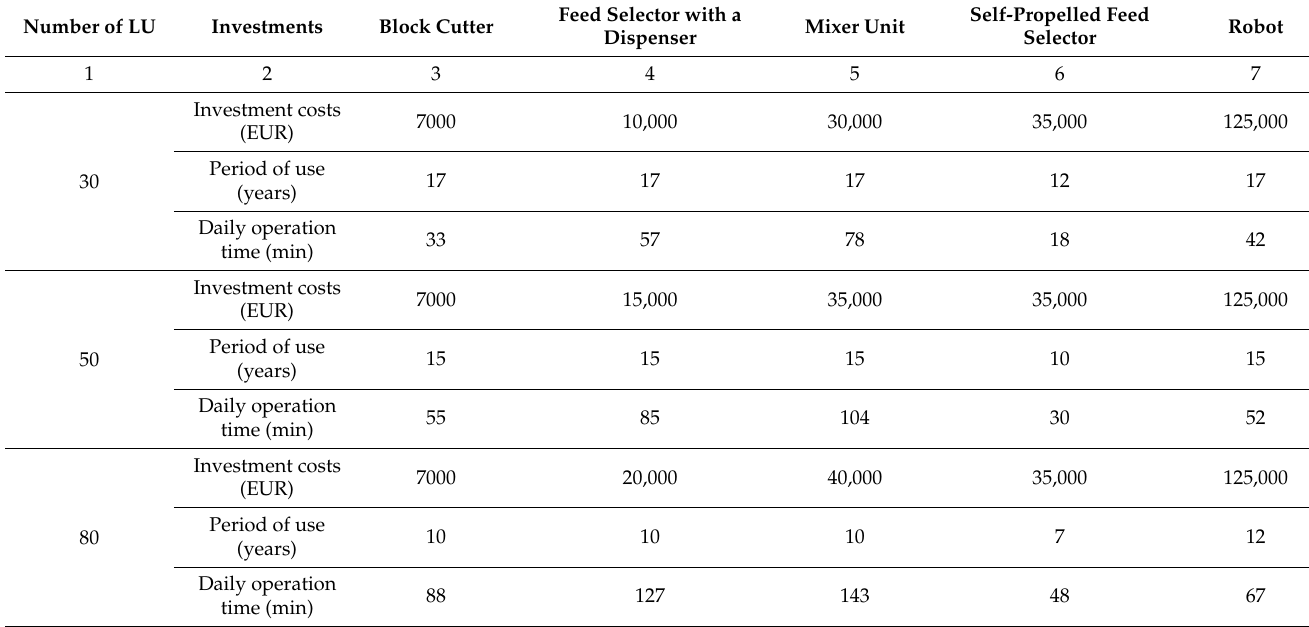
Table 2. Analysis of investment costs, use period, and feed mixing and feeding line operation time in barns with stocking densities of 30, 50, and 80